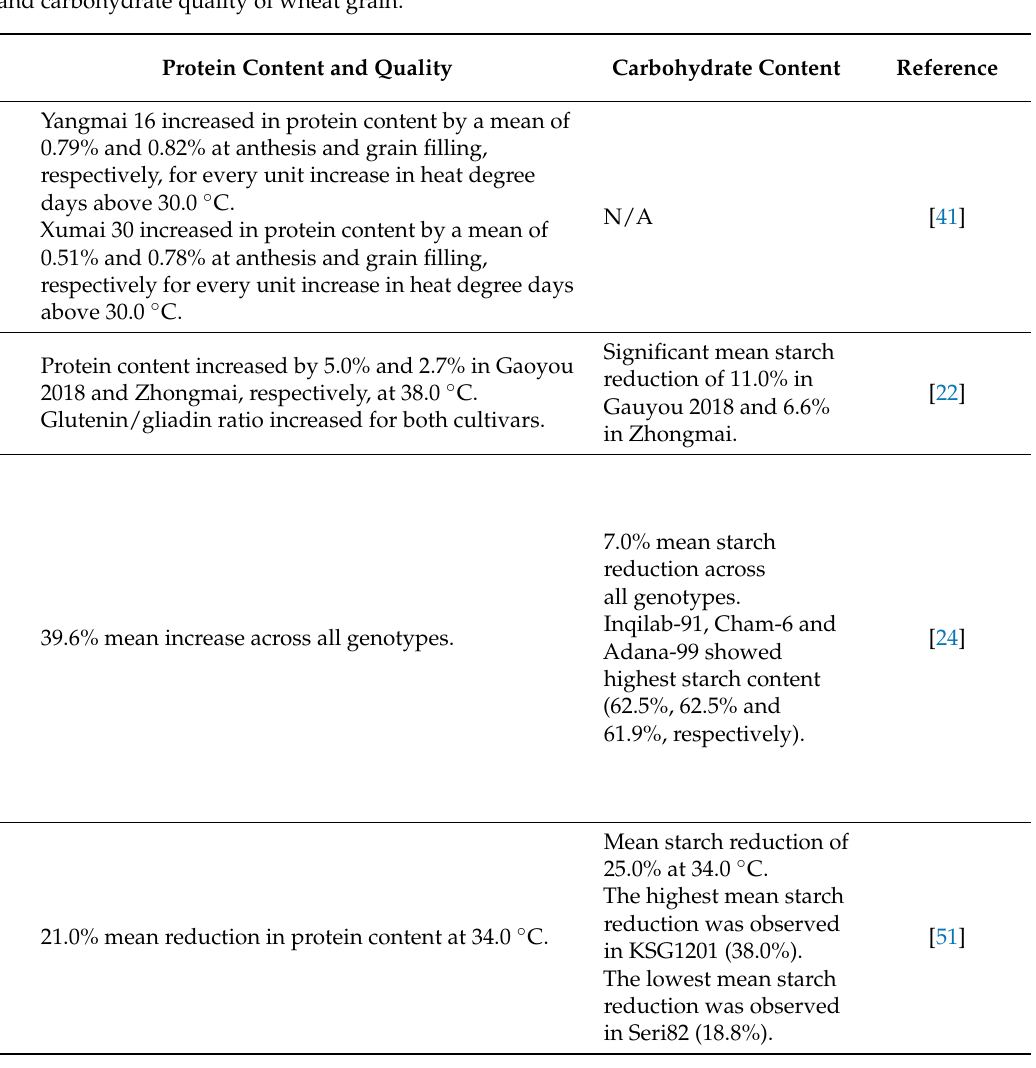
Table 3. The effect of post-anthesis heat stress on protein and carbohydrate quality of wheat